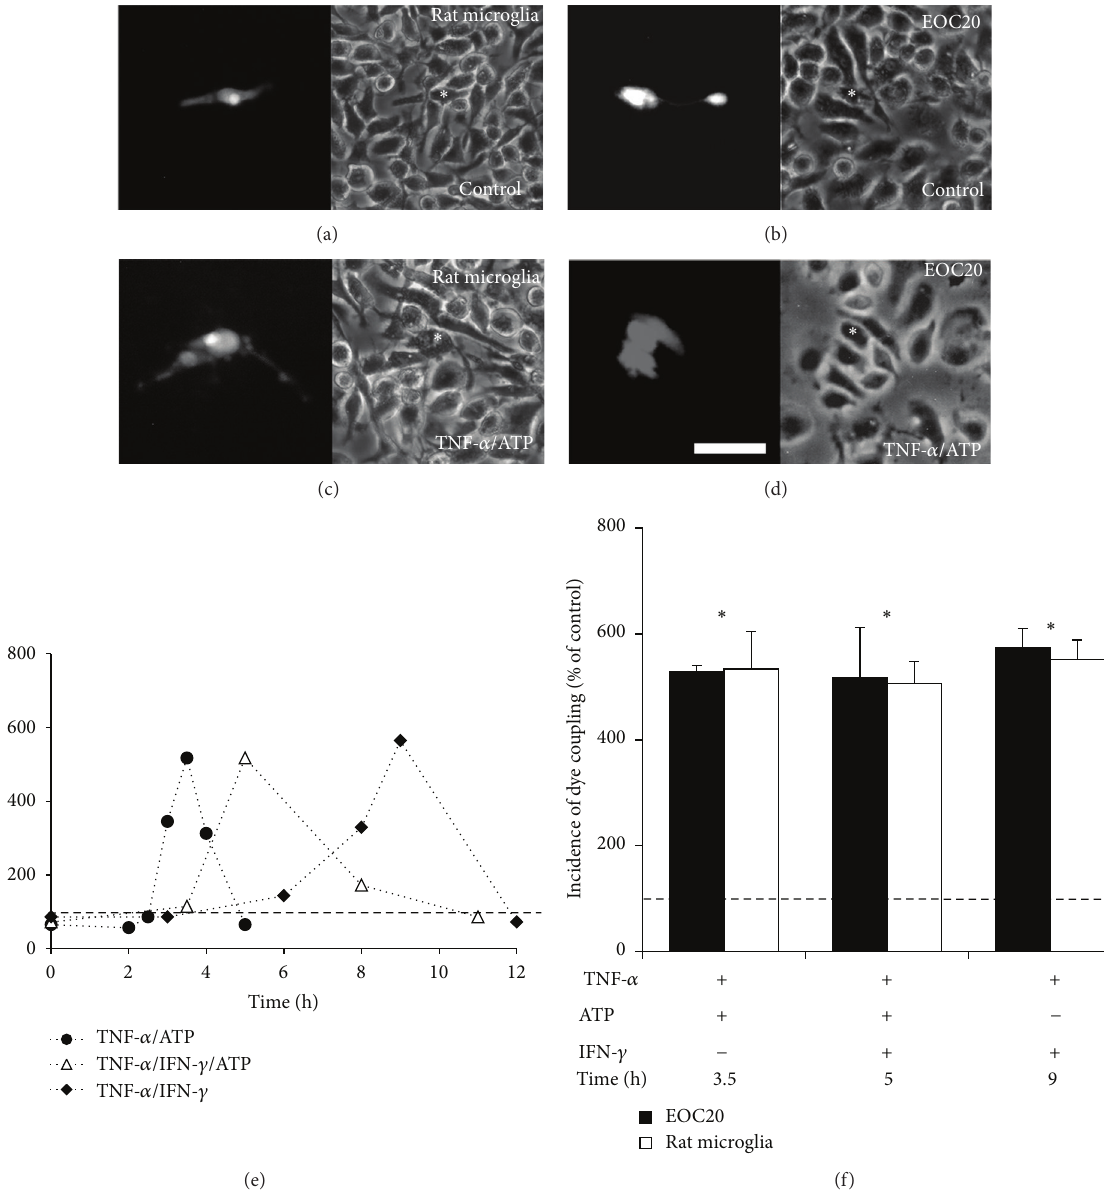
Figure 1: ATP advances the onset of TNF- 𝛼 /IFN- 𝛾 -induced dye coupling. (a)–(d) Dye transfer was evaluated 2min after Lucifer yellow (LY) microinjection in a single cell (indicated with an asterisk). Representative pictures of LY transfer in rat microglia (a), (c) or EOC20 cells (b), (d) under control condition or after TNF- 𝛼 plus ATP (TNF- 𝛼 /ATP) treatment for 3.5h, as indicated. Phase contrasts of each micrograph are shown at the right panels. Scale bar: 20 𝜇 m. (e) Time course of the incidence of dye coupling (IDC) as percentage of IDC in EOC20 cells under control conditions (dashed line) or after treatment with TNF- 𝛼 plus ATP (black circles), TNF- 𝛼 /IFN- 𝛾 plus ATP (white triangles), or TNF- 𝛼 /IFN- 𝛾 (black diamonds). Each point corresponds to the mean of 3 independent experiments. (f) Graph showing the maximum values of IDC after treatment with TNF- 𝛼 plus ATP for 3.5 h, TNF- 𝛼 /IFN- 𝛾 plus ATP for 5h, or TNF- 𝛼 /IFN- 𝛾 for 9h. ∗ 𝑃 < 0.05 versus control condition. Each bar represents the mean ± SEM, 𝑛 = 6 . No significant differences were observed when comparing microglia and EOC20 cells responses to different treatment in dye transfer assays. Concentrations: 1ng/mL TNF- 𝛼 ; 1mM ATP; 1ng/mL IFN- 𝛾 .